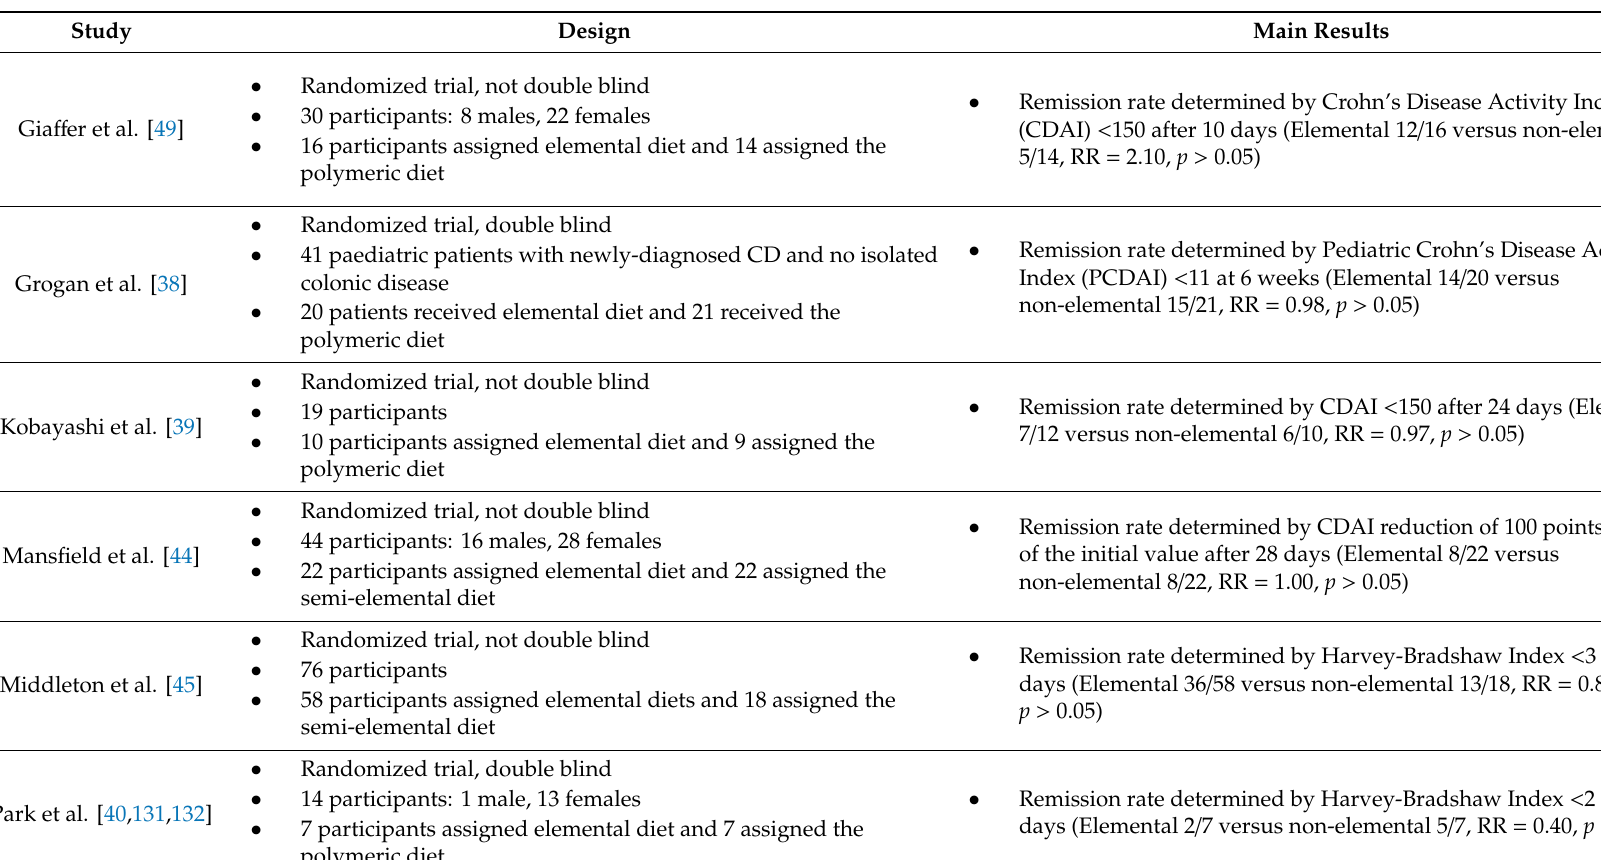
Table 3. Examples of studies that examined remission of CD with